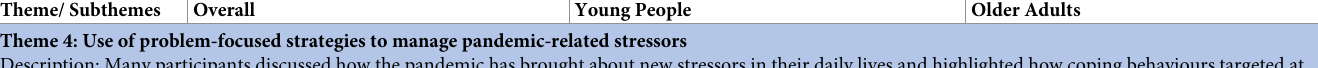
such stressors have been